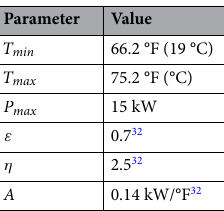
Table 3. Main parameters of HVAC system and